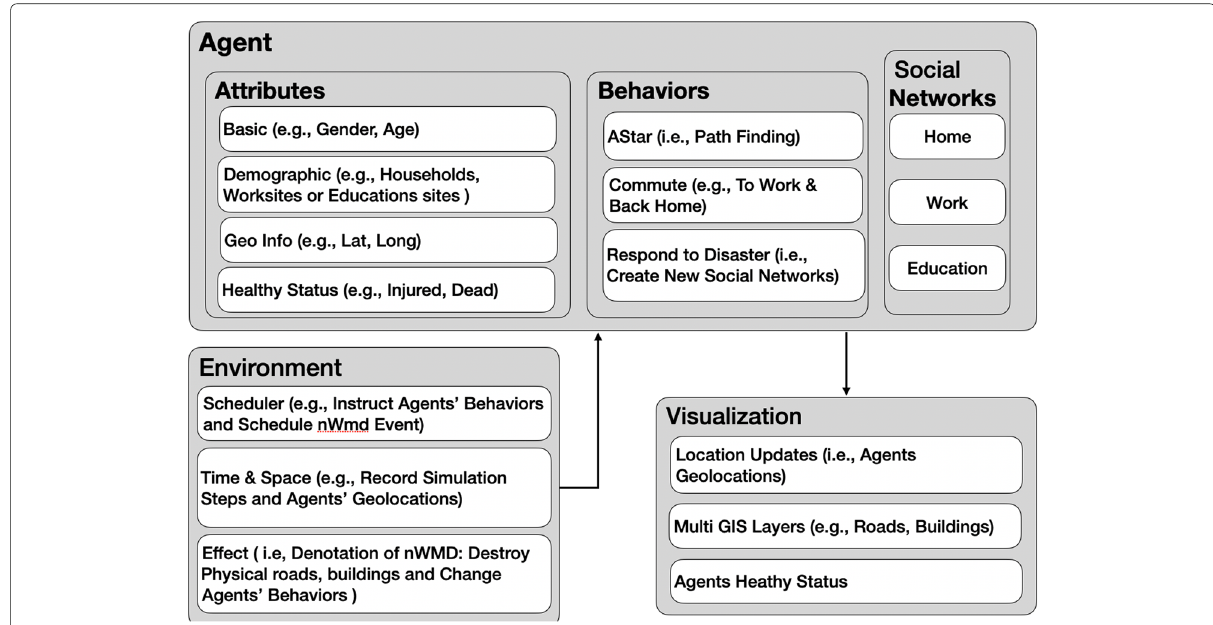
Fig. 12 Model Component Structure of Population Respond to Disaster